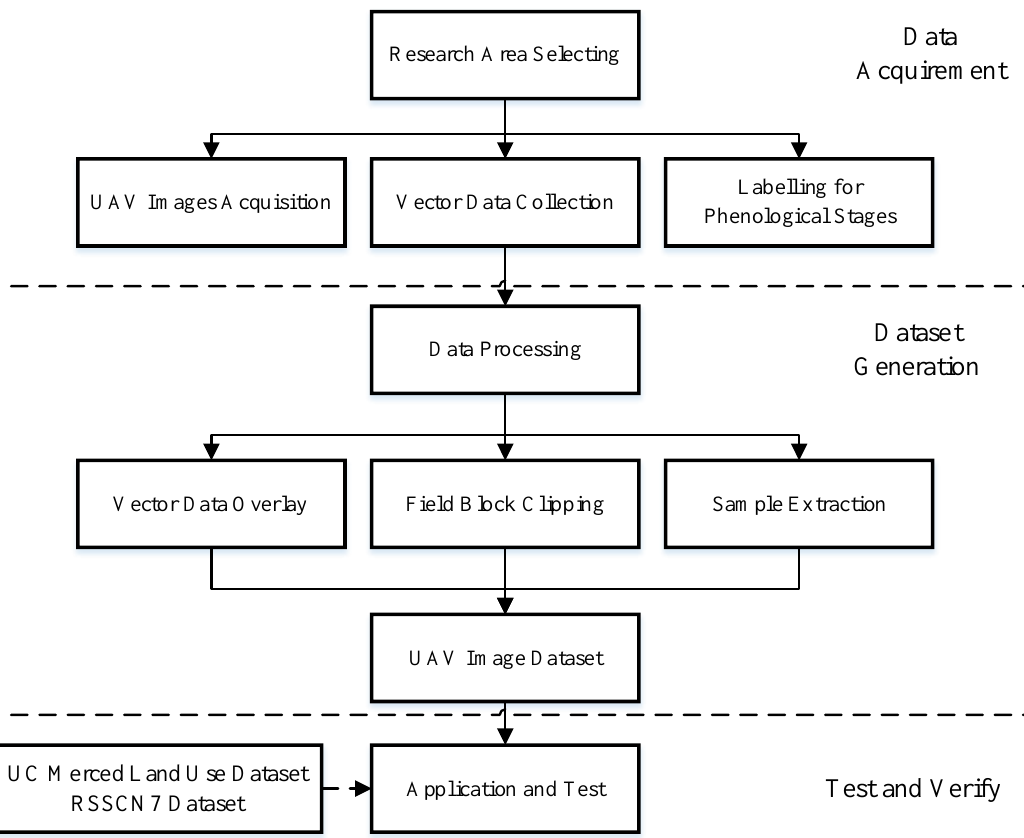
Figure 4. The overview flowchart of the processing. This is divided into three steps. The data preparation is for the data acquisition and preparation. The generation stage is building the dataset, and the test stage is the evaluation of the